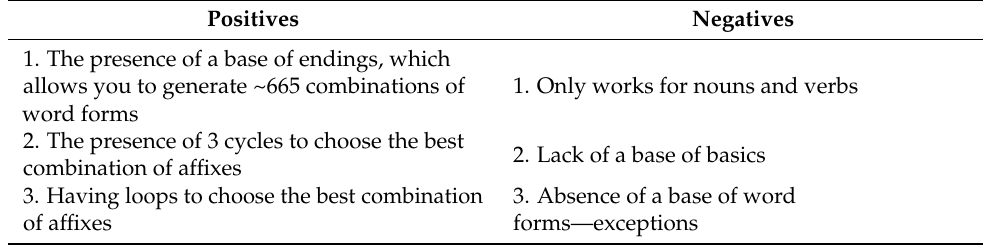
Table 2. Positive and negative sides of UKNT.